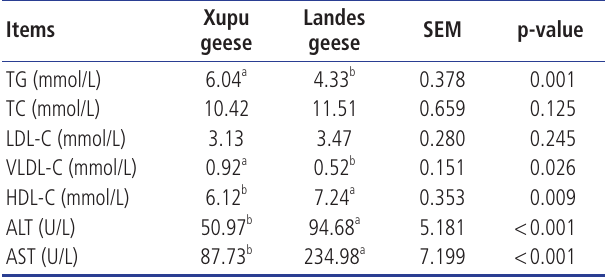
Table 5. Comparison of plasma biochemical metabolites between overfed Xupu and Landes geese